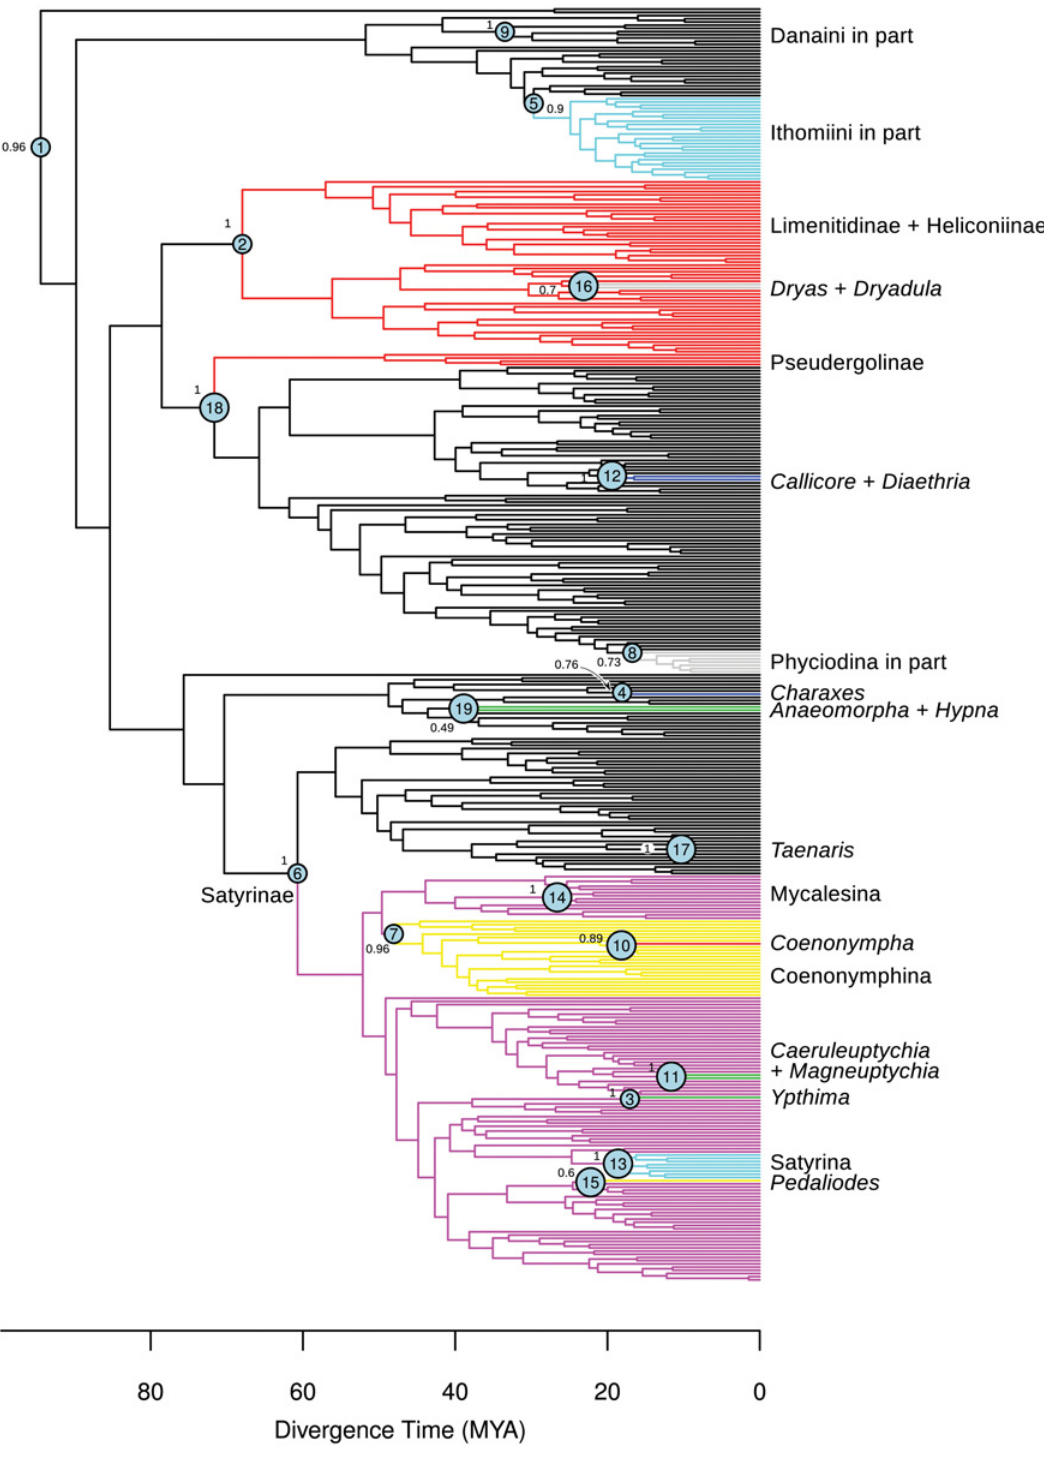
Fig 1. Results of the MEDUSA analysis run on the maximum clade credibility tree from Wahlberg et al. (2009). Rate shifts were estimated for the following nodes (besides the background rate): 1) root, 2) Limenitidinae + Heliconiinae, 3) Ypthima , 4) Charaxes , 5) Ithomiini in part, 6) Satyrinae, 7) Coenonymphina 8) Phyciodina in part, 9) Danaini in part, 10) Coenonympha , 11) Caeruleuptychia + Magneuptychia , 12) Callicore + Diaethria , 13) Satyrina, 14) Mycalesina, 15) Pedaliodes , 16) Dryas + Dryadula , 17) Taenaris , 18) Pseudergolinae, 19) Anaeomorpha + Hypna . Circles on nodes indicate the diversification shift number as found by MEDUSA. Numbers next to circles indicate the posterior probability values for such nodes.